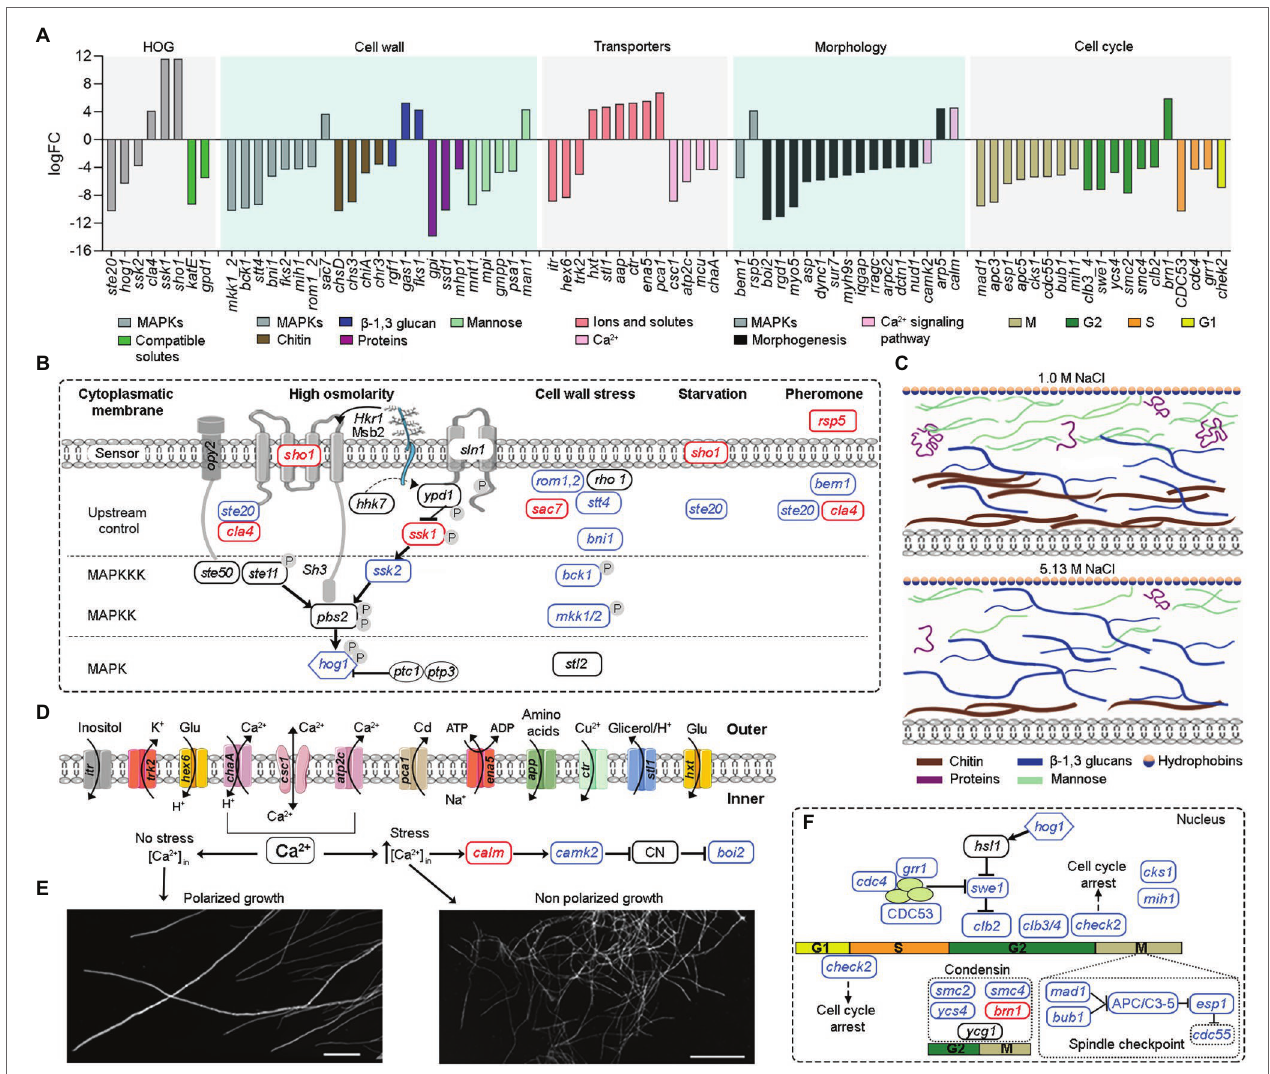
FIGURE 4 | Overview of the main tolerance mechanisms of A. sydowii cultured at saturated NaCl concentration (5.13 M NaCl) compared to optimal salt concentration for growth (1 M NaCl). (A) Bar graph showing the logFC values of all differentially expressed genes involved in high osmolarity glycerol pathway (HOG), cell wall biosynthesis, cellular membrane transporters, mycelium morphology, and cell cycle. (B) Genes related to the MAPK signaling pathways that respond to a hyperosmolarity condition. Red, blue, and black boxes/letters indicate genes upregulated, downregulated, and non-differentially expressed, respectively. (C) Composition of the cell wall in the two conditions studied inferred from the expression of genes involved in the synthesis of the cell wall components (chitin, proteins—hydrophobins are shown particularly— β -13-glucans and mannose). (D) Differentially expressed cytoplasmic membrane transporters at saturated NaCl concentration. (E) Electron microscopy of A. sydowii cultured at 1 M NaCl (polarized growth) and 5.13 M NaCl (non-polarized growth). Scale bars = 100 μ m. (F) Differentially expressed genes related to the cell